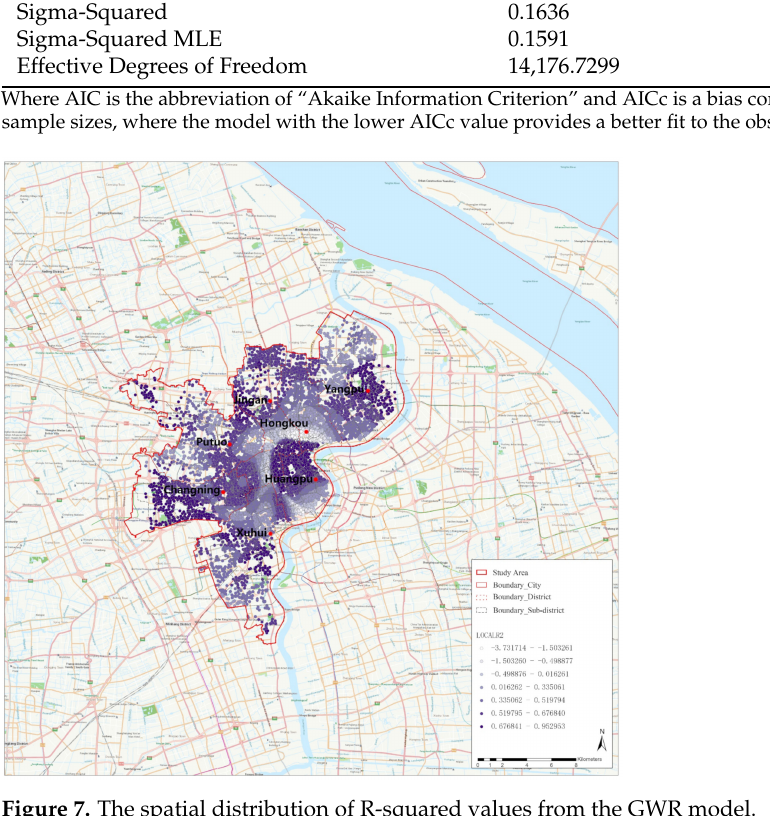
Figure 7. The spatial distribution of R-squared values from the GWR